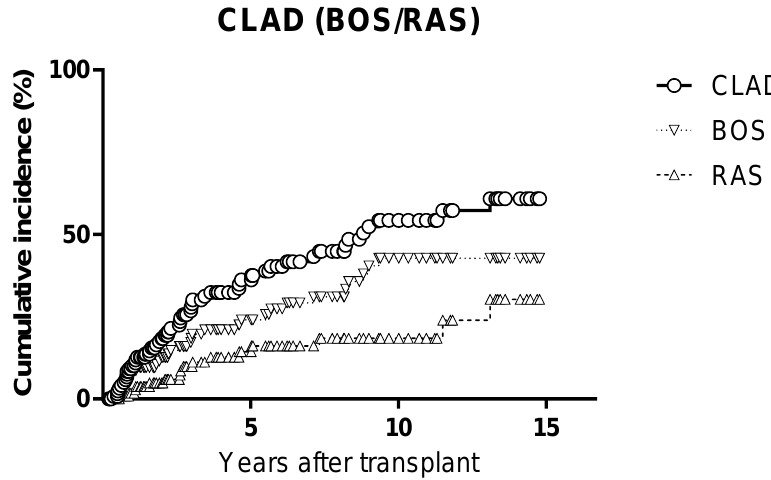
Figure 2. Cumulative incidence of CLAD, BOS and RAS.